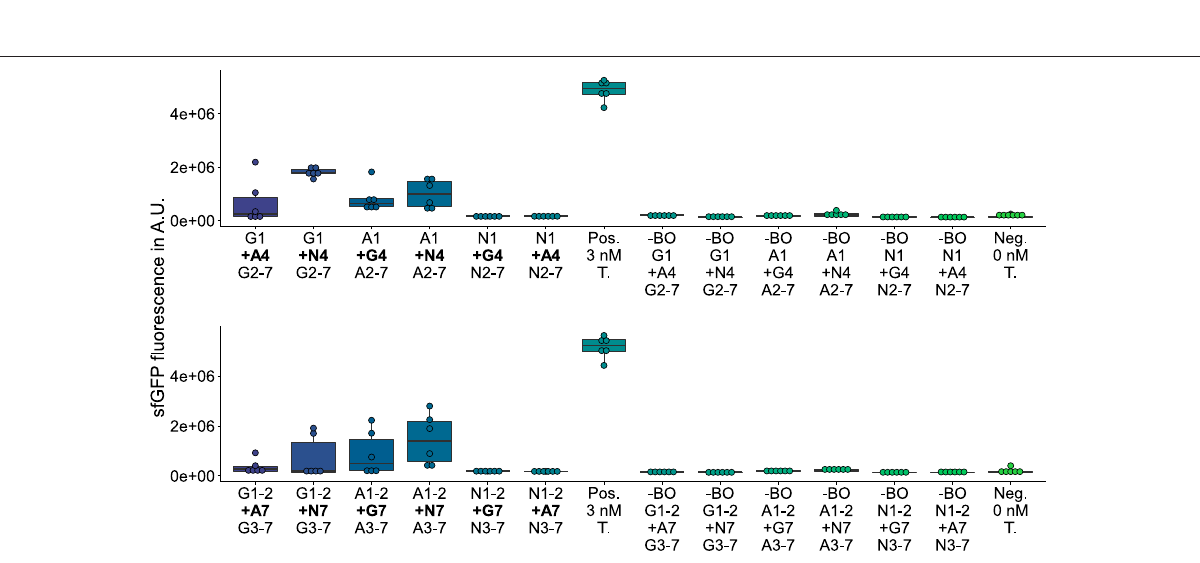
Frontiers in Bioengineering and Biotechnology |